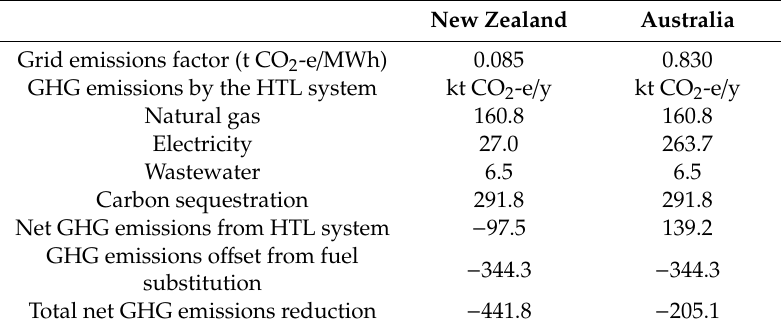
Table 5. Comparing GHG emissions between New Zealand and